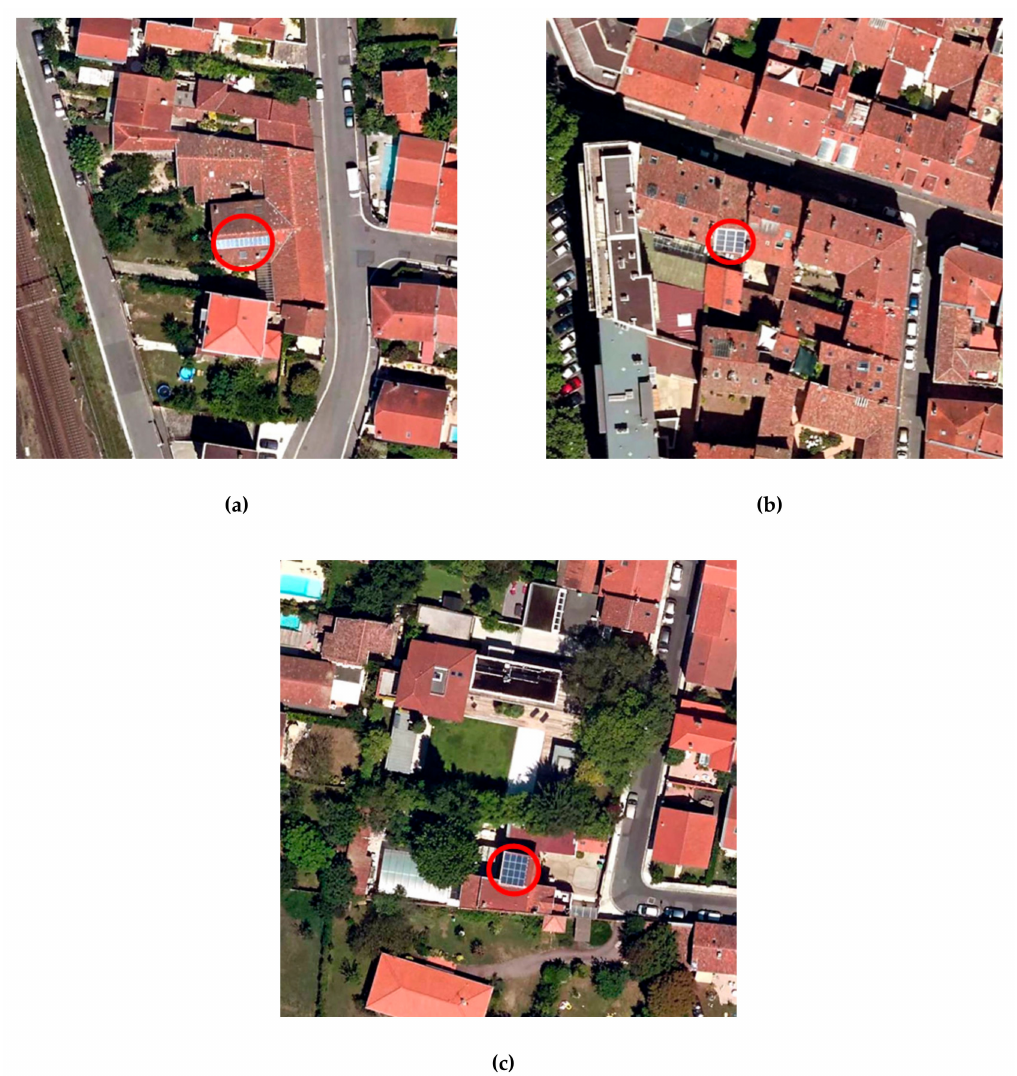
Figure 7. The three considered very high-spatial-resolution RGB ortho-images corresponding to the three selected hyperspectral sub-images: ( a ) ortho-image 1, ( b ) ortho-image 2, and ( c ) ortho-image 3. Red circles surround photovoltaic